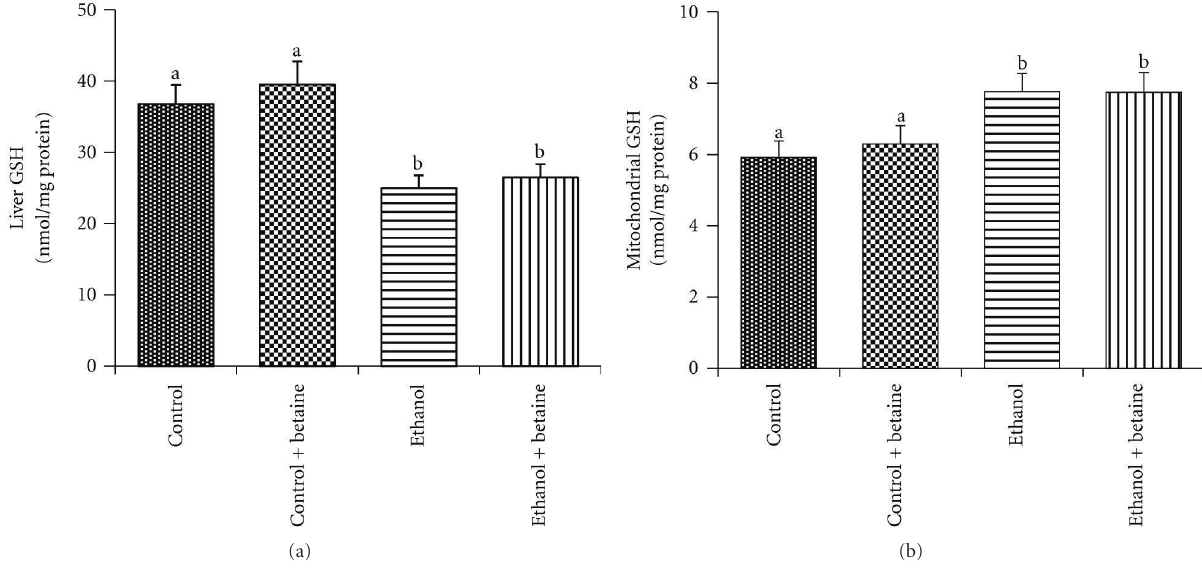
Figure 6: Betaine and ethanol increase mitochondrial GSH levels. HPLC was employed to determine GSH levels in (a) liver and the (b) mitochondrial fractions from control, ethanol, control + betaine, or ethanol + betaine groups. Data represent the mean ± S.E.M. for n = 8 animals per group. Values not sharing a common letter are statistically di ff erent, P < 0 .